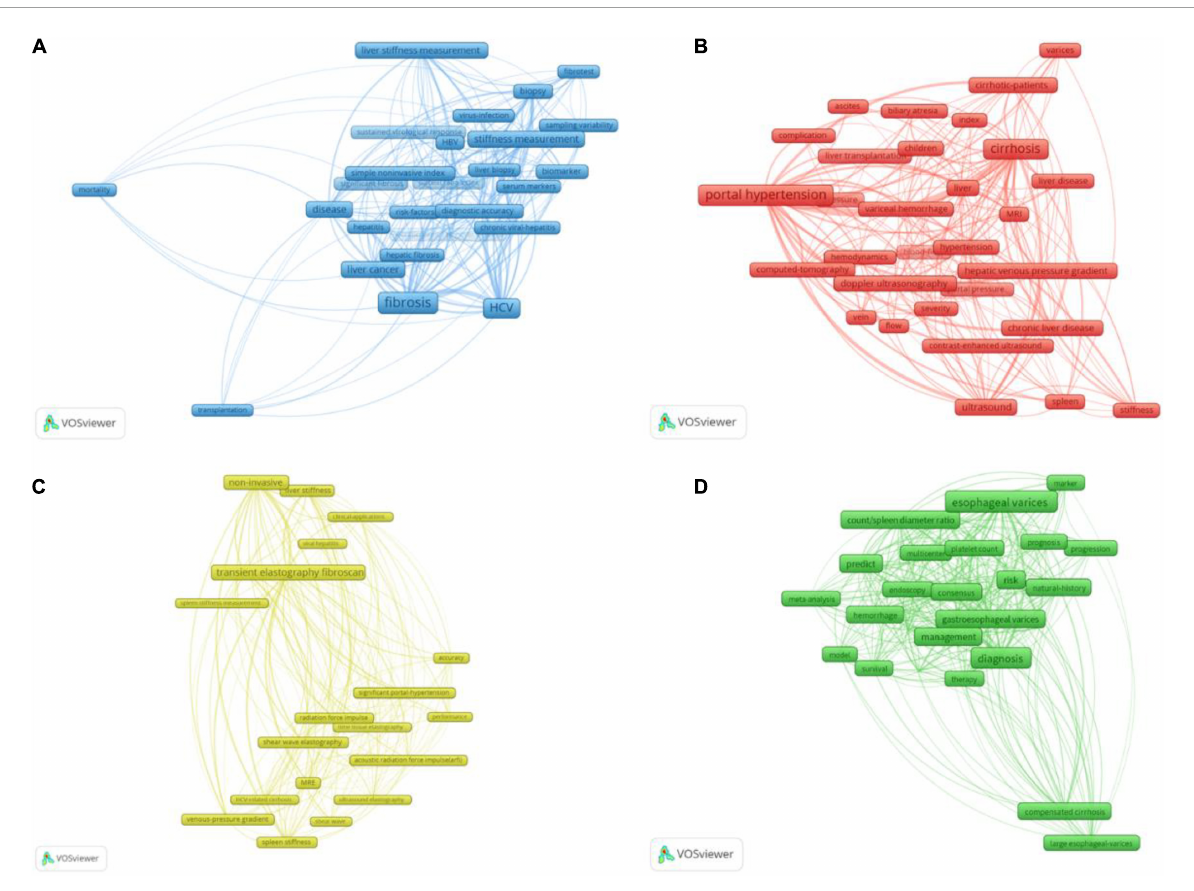
FIGURE5 The four clusters of the 102 keywords occurred over 20 times. The size of frames represented the occurrence times of the keywords, and the line thickness indicated the link strength between the keywords at either end. Panel (A) is Cluster 3 about the evaluation of portal hypertension based on fibrosis. This cluster included 26 keywords, and “fibrosis” was the highest frequency. The keywords relating to the method of PH evaluation were “liver stiffness measurement,” “fibrotest,” “stiffness measurement,” “biomarker,” “serum markers,” and “platelet ratio index.” Panel (B) was Cluster 1 about the evaluation of portal hypertension based on hemodynamic factors. There were 30 keywords, and “portal hypertension” was the highest frequency. The referred indices included “blood-flow,” “hemodynamics” and “ascites,” and referred methods were “ultrasound,” “Doppler ultrasonography,” “contrast-enhanced ultrasound,” “computed-tomography” (CT), and “MRI.” Panel (C) was Cluster 4 about the evaluation of portal hypertension through elastography. There were 20 keywords and “transient elastography fibroscan” was the highest frequency. Elastography could be divided into “ultrasound elastography” and “MRE,” and “transient elastography fibroscan” was the most commonly used method of “ultrasound elastography.” Panel (D) Was Cluster 2 about the evaluation of portal hypertension-induced variceal bleeding. There were 26 keywords and “esophageal varices” was the highest frequency. This cluster is also referred to “platelet count” and “count/spleen